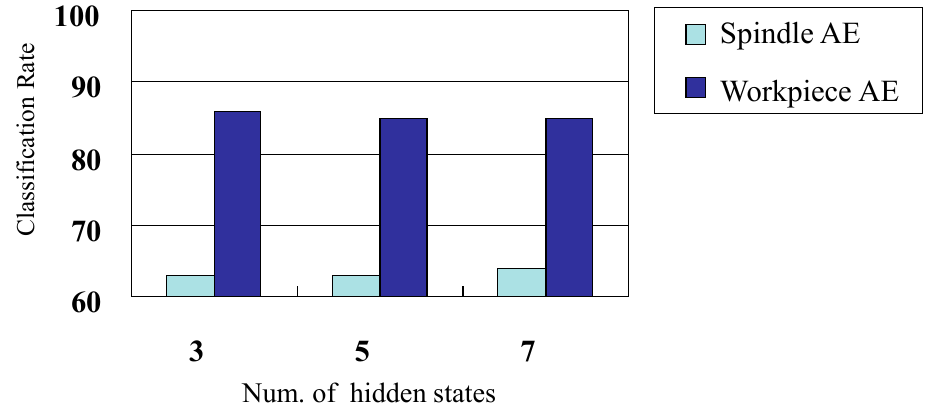
Figure 18. Effect of hidden state on the classification rate of tool wear condition (16 KHz feature bandwidth).